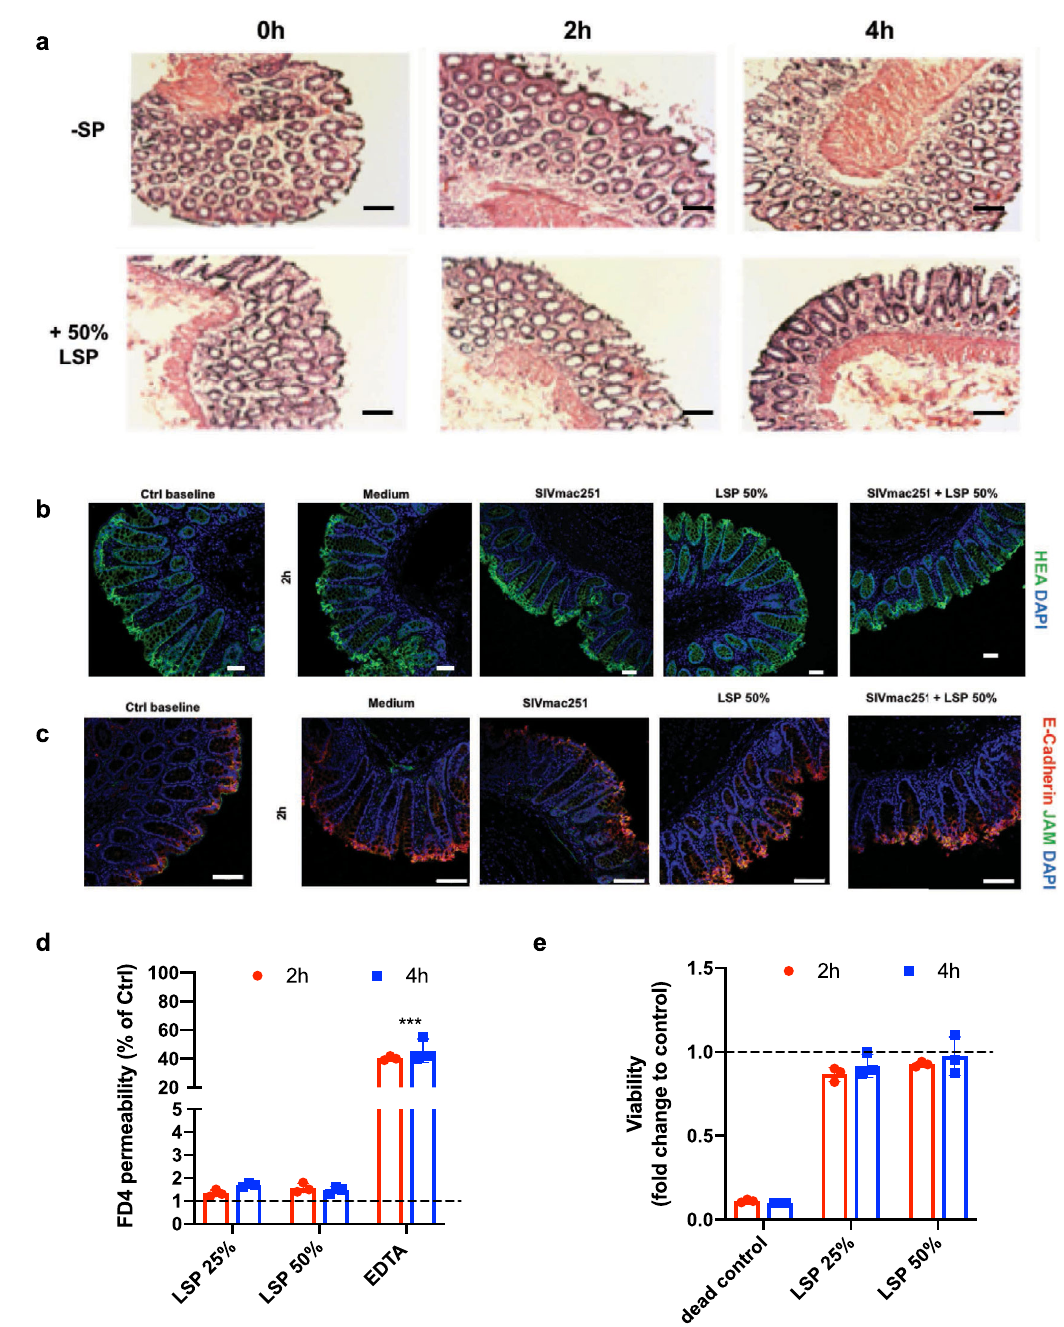
Fig. 3 Ex vivo evaluation of seminal plasma toxicity. a Representative histology (H&E staining) of the explant before and after 2 and 4 h of culture with or without 50% LSP, showing intact epithelium. Magni fi cation ×20. Scale bar = 50 µ m. b , c Immuno fl uorescence staining for the human epithelial antigen (HEA-FITC, green), E-cadherin (red), and the junctional adhesion protein (JAM, green) of explants before and after treatment for 2 h with culture medium (negative control), SIVmac251 with or without 50% LSP, and 50% LSP. Scale bar = 50 µ m in ( b ) and 100 µ m in ( c ). d Integrity of the epithelial barrier measured by the addition of Dextran-FITC (FD4, 4 kDa, 250 µ g/ml) to the apical side of the explant with or without 25% or 50% LSP for 2 and 4 h. Results are shown as the percentage of positive control (dye added to the basal medium at the beginning of the experiment). EDTA (100 mM) was included as a control of barrier disruption. The statistical signi fi cance between conditions was tested using Wilcoxon signed-rank tests, *** p < 0.0005. e Viability of the explants exposed, or not, for 2 and 4 h to 25% or 50% LSP measured by the MTT assay. A solution of 10% bleach was included as a control for death. Results are shown as the mean ± SD of triplicates from a representative experiment of